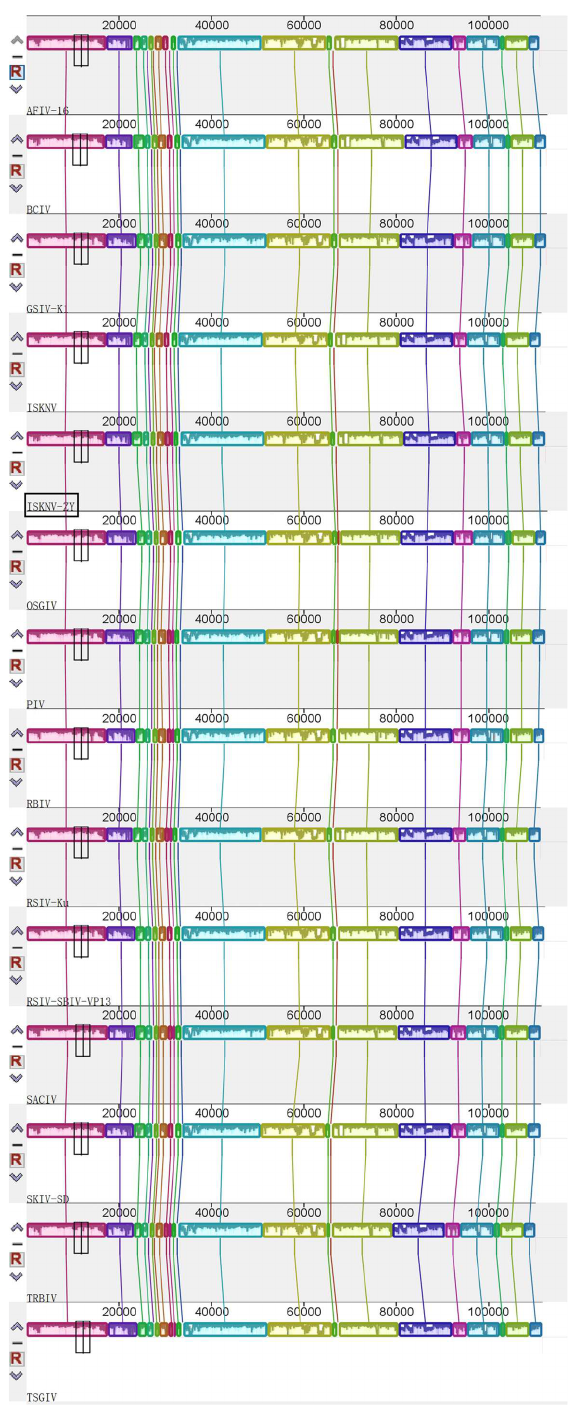
Figure 4. Genome collinearity between infectious spleen and kidney necrosis virus (ISKNV)-ZY and other Megalocytiviruses . Data were obtained on 8 October 2021 using the MAUVE software (http: //darlinglab.org/mauve/mauve.html), which analyzes population evolutionary events through multiple sequence comparisons. Accession numbers of viral genomes are: OSGIV, AY894343; ISKNV, NC_003494; RBIV, AY532606; BCIV, MN432490; RSIV-Ku, KT781098; RSIV-SBIV-VP13, ON740976; TRBIV, GQ273492; TSGIV, MG570132; SACIV, MG570131; SKIV-SD, MT986830; GSIV-K1, KT804738; AFIV-16, MK689685 and PIV,